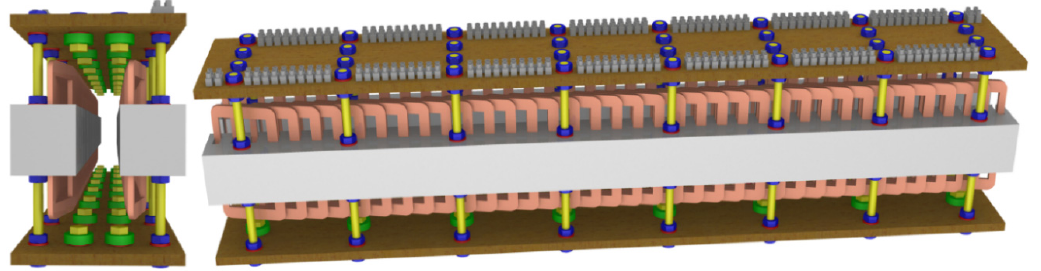
Figure 4. Lateral and front views of stator.